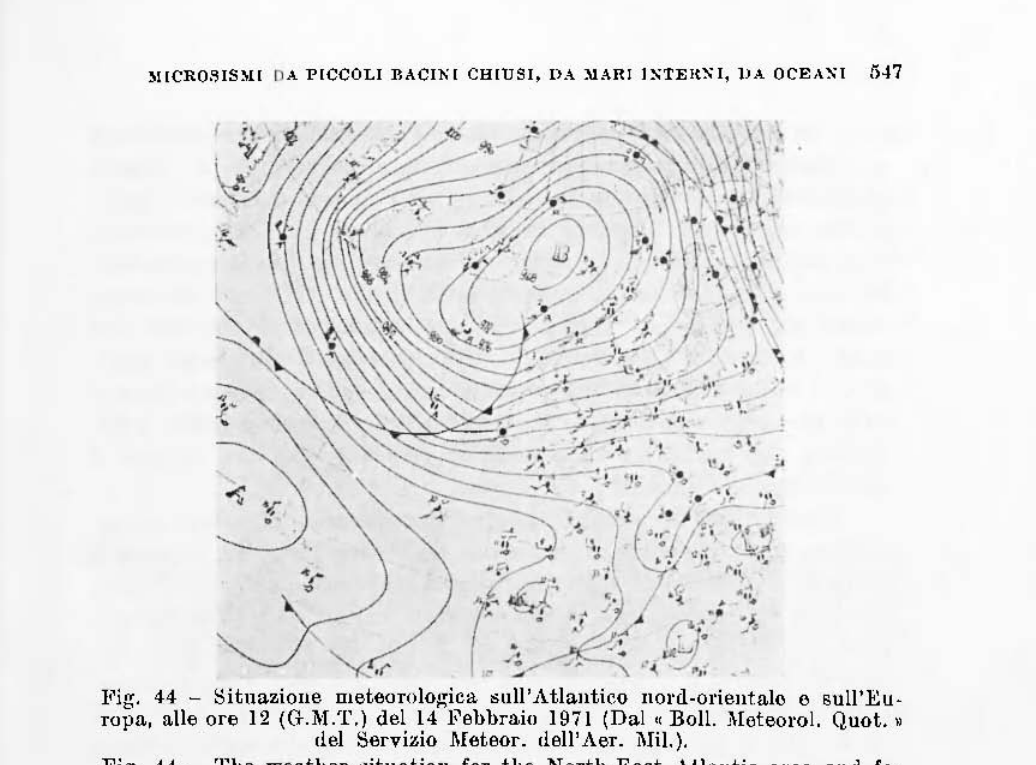
Fig. 44 - ~ituaziolle meteorolog-ica sull'Atlantko nord-orientale e sull'Eu ropa, alle ore 12 (G.],'f.T.l del 14 Pebbraio 1971 (Dal" Boll. Meteoro!. Quot.. del ~ervizio Meteor. dell'Aero Mi!.). - The weather sitllation for the North·Rast Atlantk area and far Fig. 44 at midday (G.M.T.) of Febr. 14, 1971 (froUl the naily Meteoro Europe logical .Bulletin of the Weather ~ervke of the Ah Force) .